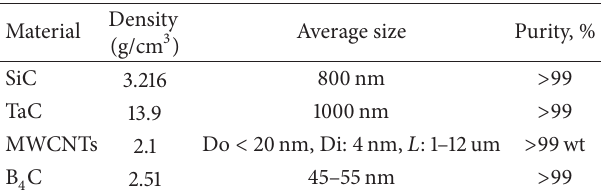
Table 1: Specification of materials